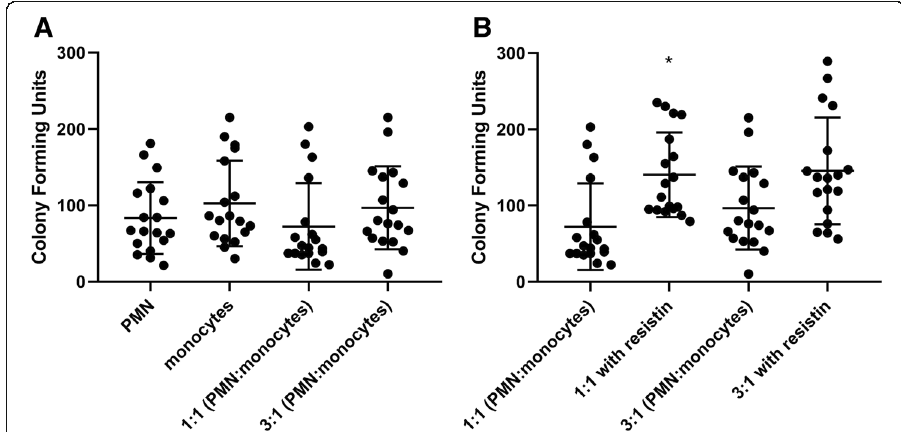
Fig. 3 Effect of co-incubation of PMN (neutrophils) and monocytes on bacterial killing of P. aeruginosa with different ratios of PMN to monocytes in the a absence of resistin and b presence of resistin. Direct co-incubation was achieved by mixing PMN and monocytes in 1:1 ratio and 3:1 ratio (total cell counts kept the same in each condition). Co-incubation with increasing proportions of monocytes did not improve killing of P. aeruginosa . n = 18 for all experiments. Asterisk denotes statistical significance ( P < 0.05)